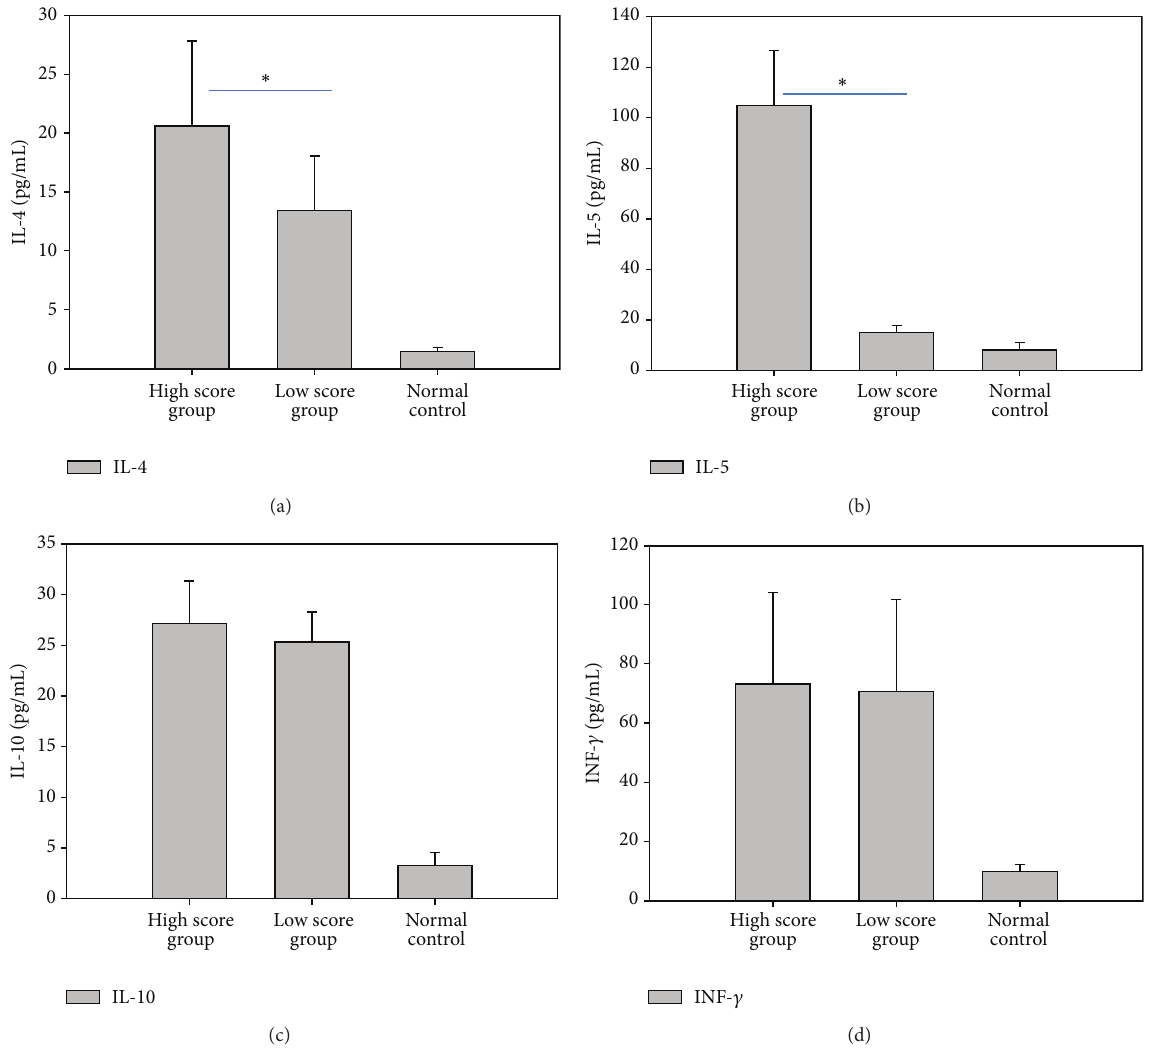
Figure 4: Serum cytokine levels in MPP patients with severe pneumonia and high or low CPIS values. Among the 107patients with severe MPP, serum cytokine levels were assessed in those with high CPIS ( ≥ 6points; 𝑛 = 75) and low CPIS ( < 6points; 𝑛 = 32). The results for 𝑛 = 50 control subjects without pneumonia are shown for comparison. For all four cytokines tested, the levels for both the high and low score groups were statistically higher than the levels in the normal control subjects, while the IL-4 and IL-5 levels were further elevated in the high score group. Results represent the mean ± standard deviation. ∗ 𝑃 < 0.01 for high versus low CPIS